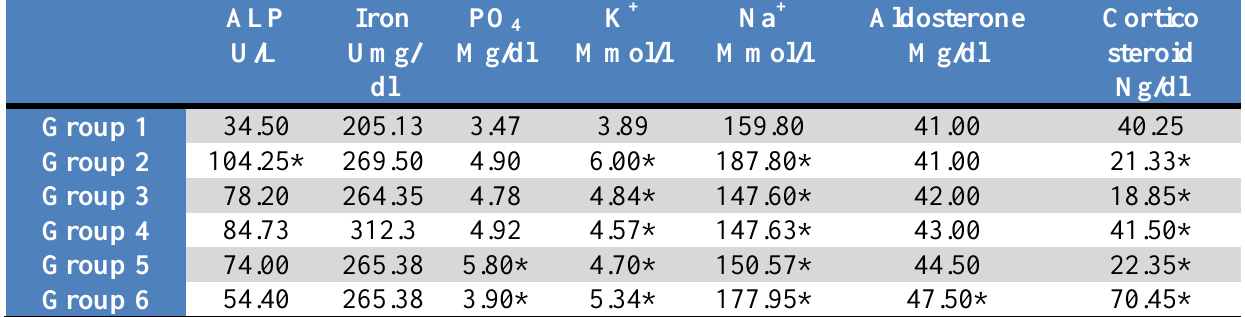
Table 1: Effect of aqueous extract of Tribulus terrestris on ALP, Iron, PO4, Na+, K+, aldosteron, and cortico steroid concentration in different groups of